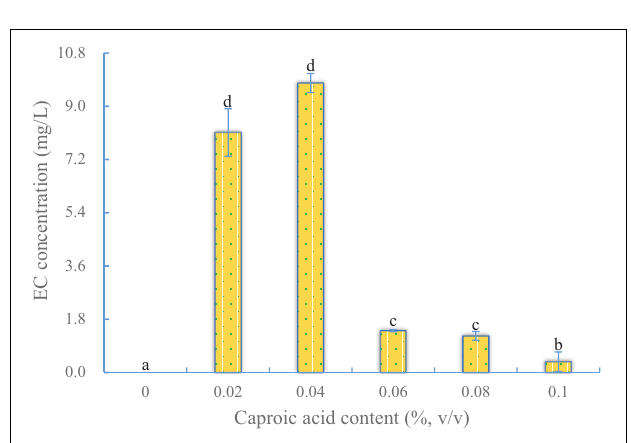
FIGURE 2 | Effect of ethanol content on EC production by YX3307. Same letters in the column indicates that the data do not differ significantly at 5% probability by the Tukey test.